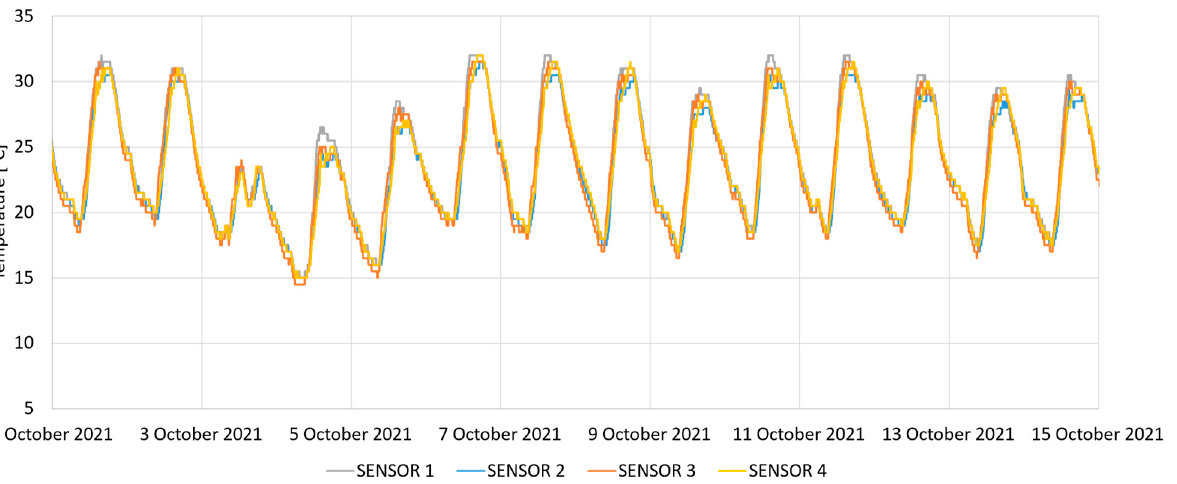
Figure 7. Temperatures are measured by the four fixed sensors put in the open-air space at the school entrance. Table 3. Variables measured by the semi-mobile